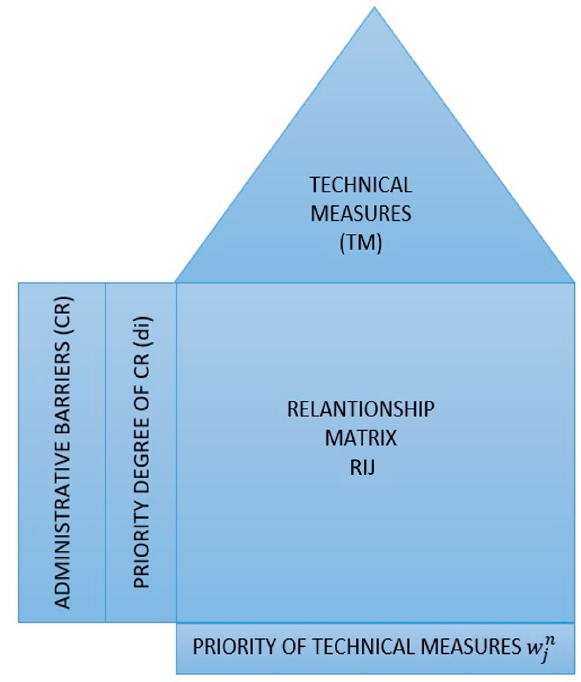
Figure 1. House of